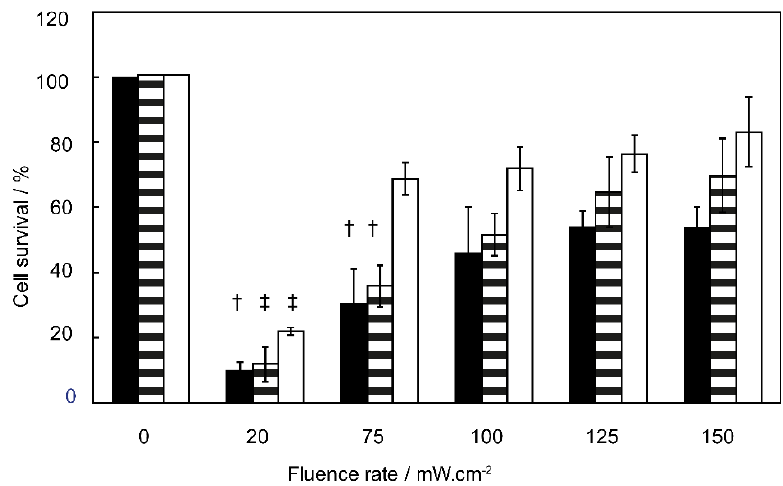
Figure 1. Cell survival of OSC-19-luc2-cGFP (black bar), scc-U2 (striped bar), and scc-U8 (white bar) treated with cetuximab-IRDye700DX using a 24 h DLI and illuminated with different fluence rates to a fluence of 15 J·cm − 2 for OSC-19-luc2-cGFP and scc-U2 and 7 J·cm − 2 for scc-U8. † statistically significant from all other fluence rates investigated with the same cell line with p < 0.05 , ‡ statistically significant from all other fluence rates investigated with the same cell line with p < 0.01.